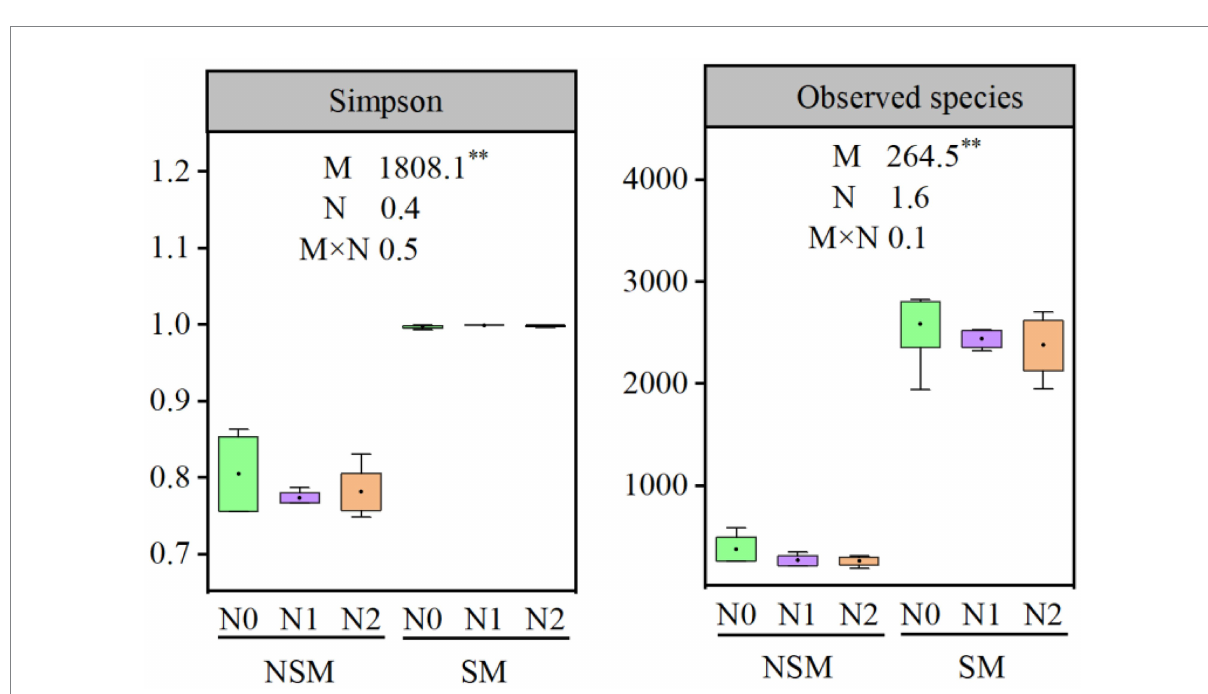
α -diversity of bacterial communities in wheat rhizosphere soil under straw mulching and N fertilization treatments. M, mulching treatment; N, N fertilization treatment. M × N, the interaction of straw mulching and N fertilization. NSM, no straw mulching; SM, straw mulching; N0, no N; N1, 120 kg N ha − 1 ; N2, 180 kg N ha − 1 . **, statistically significant difference ( p <